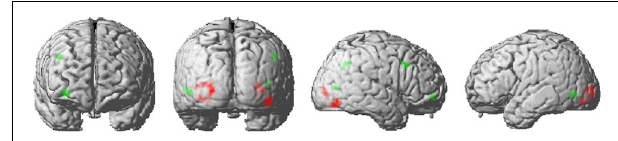
FIGURE 3 | Activation clusters revealed by the whole brain analyses. Regions that elicited decreased activation for repeated trials are illustrated in red. Green spots mark clusters where RS effects were modulated by repetition probability (i.e., interaction). All clusters were extracted at a threshold of p < 0 . 001 (uncorrected, with a minimum extent of 10